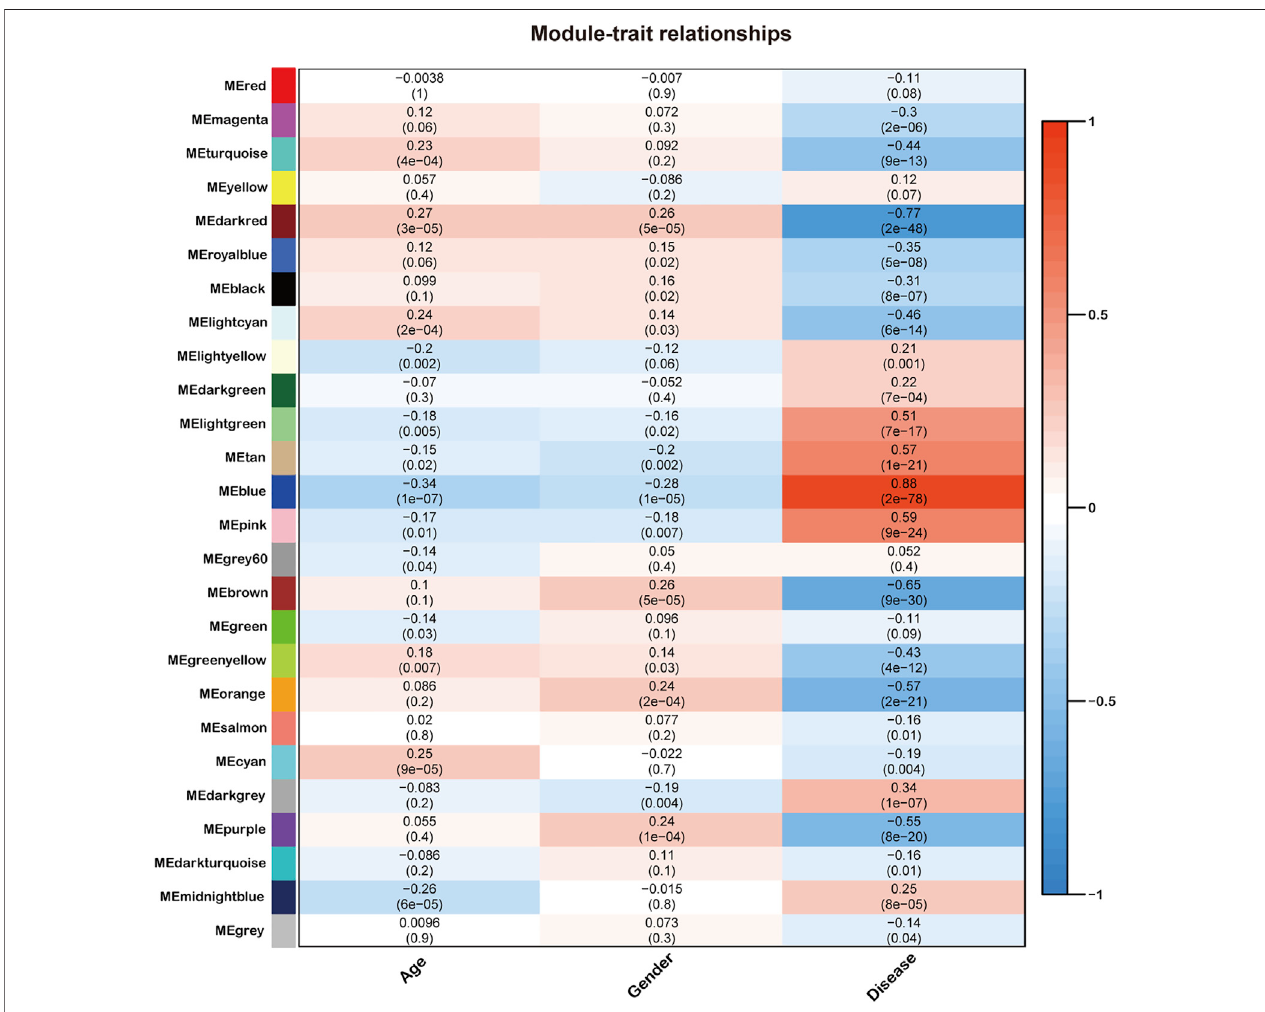
FIGURE 2 | Identi fi cation of modules associated with the clinical traits of sepsis. Heatmap of the correlation between the module eigengenes and clinical traits of sepsis. All genes were clustered into twenty-six modules, of which each was labeled with one color.